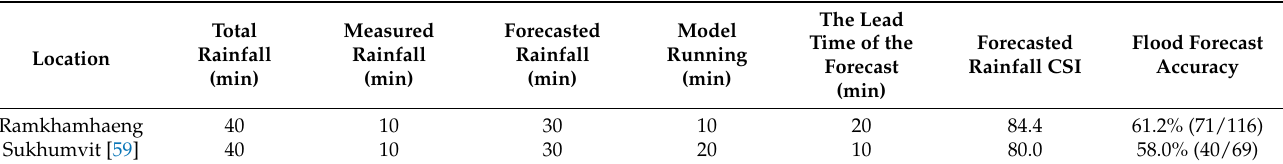
Table 2. A lead time and flood forecasting accuracy in the previous and present